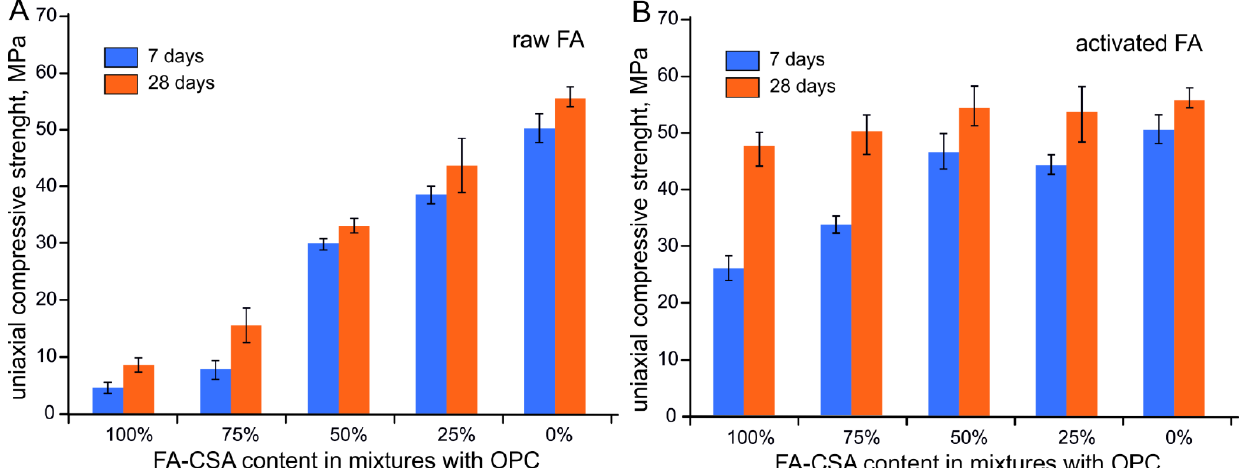
Figure 5. Average uniaxial compressive strength OPC mixture pastes with raw ( A ) and mechanically activated ( B ) fly ash after 7 and 28 days of hydration.